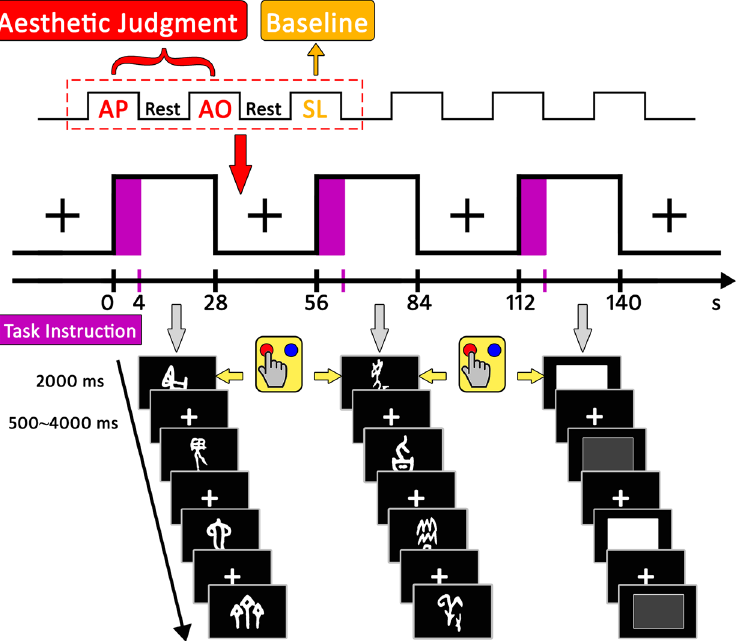
Figure 5. Experimental design, procedure and examples of stimuli. Three types of tasks were performed in separate blocks: AP judgments (beautiful pictograph vs. ugly pictograph), AO judgments (positive oracle bone script vs. negative oracle bone script), SL judgments (high luminance vs. low luminance). Examples in the first column are pictographs, referring to “rabbit”, “sacrificial mask”, “boa constrictor” and “seedling”, from top to bottom. Examples in the second column are abstract oracle bone scripts, referring to “contemptuous”, “sweet”, “catastrophic” and “courteous”, from top to bottom. Examples in the third column are grey squares, for high and low luminance,